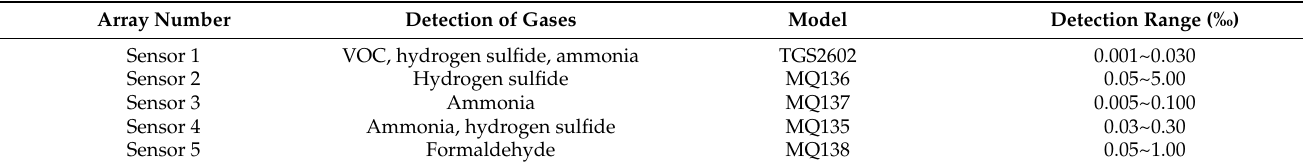
Figure 1. ( a ) Schematic diagram of the electronic nose system; ( b ) The section view of the nasal structure of the electronic nose. Table 2. Sensor serial numbers and their detection gases.